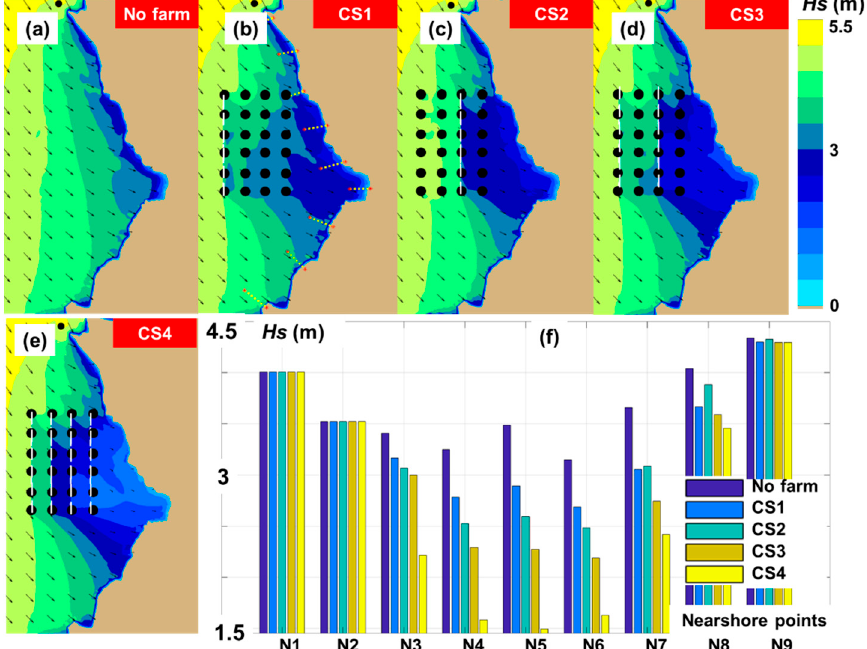
Figure 7. Influence of the generic marine farm taking into account a high energy summer event (case summer B as defined in Table 2). The results correspond to: ( a – e ) spatial variations of the wave conditions considering various scenarios; ( f ) distribution of the Hs values near the nearshore points N1–N9. The arrows field in the plot represent the wave direction.